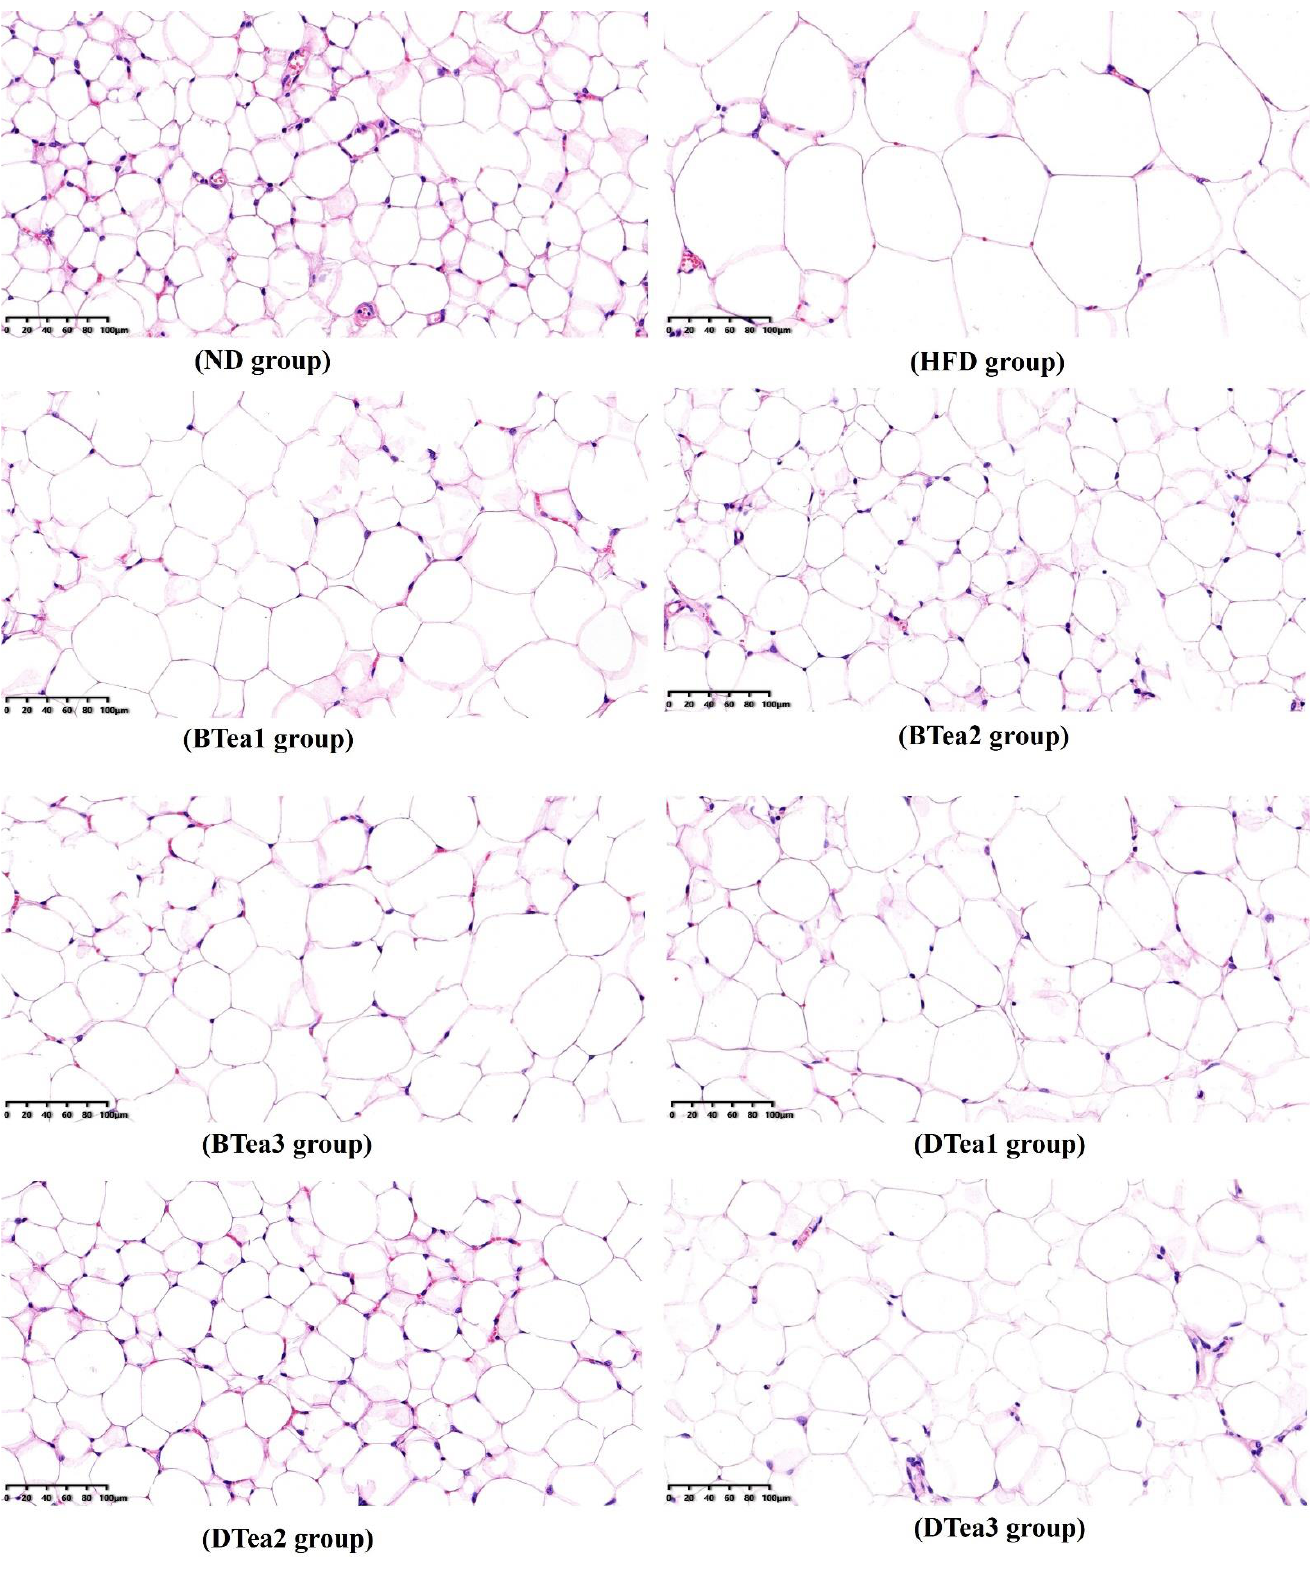
Figure 3. The histopathological changes in epididymal adipose tissue stained with hematoxylin and eosin (H&E) for all groups (magnification: 200, scale bar: 100 µm). ND, the control group (normal diet group); HFD, the model group (high-fat diet group); BTea1, selenium-enriched black tea; BTea2, Dianhong tea; BTea3, Yingde black tea; DTea1, Fu brick tea; DTea2, Liupao tea; DTea3, selenium-enriched dark tea.